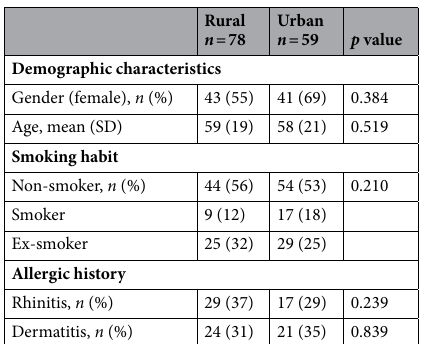
Table 2. General characteristics of the population with asthma symptoms according to the Q1 questionnaire. SD Standard